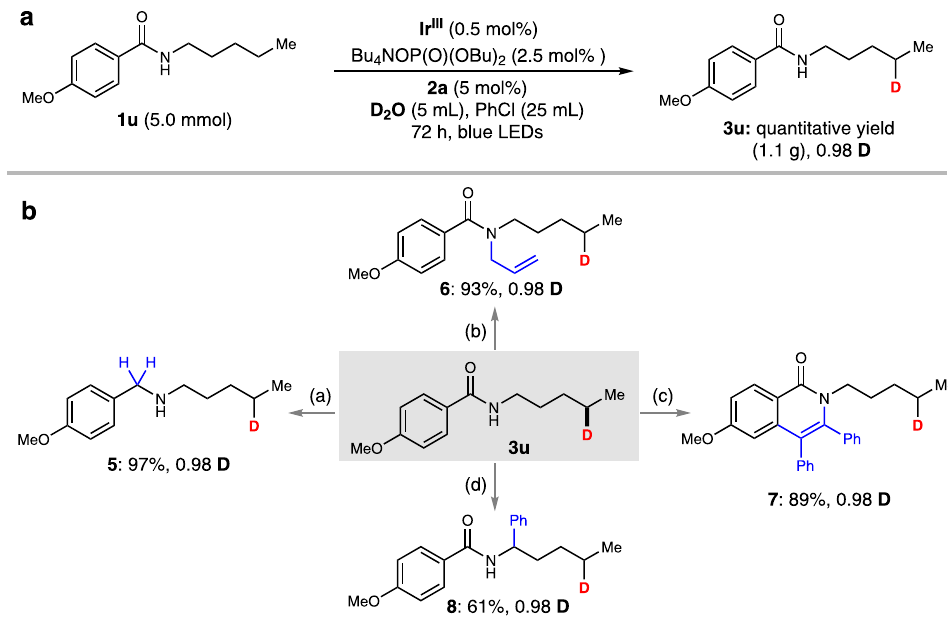
Fig. 4 Synthetic application. a 5 mmol scale-up experiment. b Downstream synthetic transformations and please see Supplementary Information for reaction conditions.